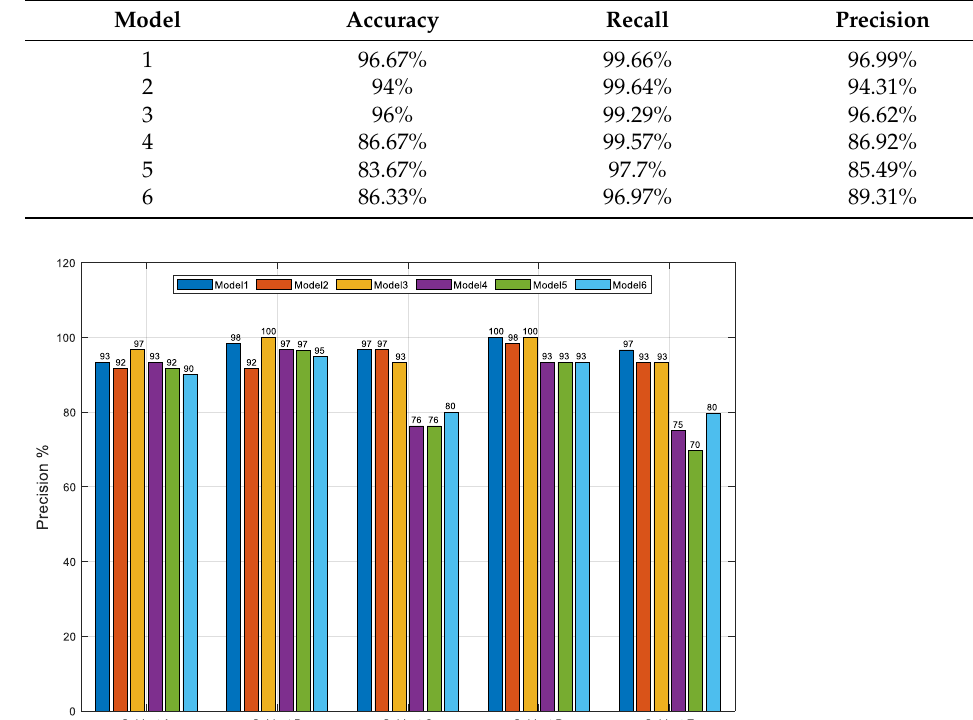
Table 2. Total performance index.